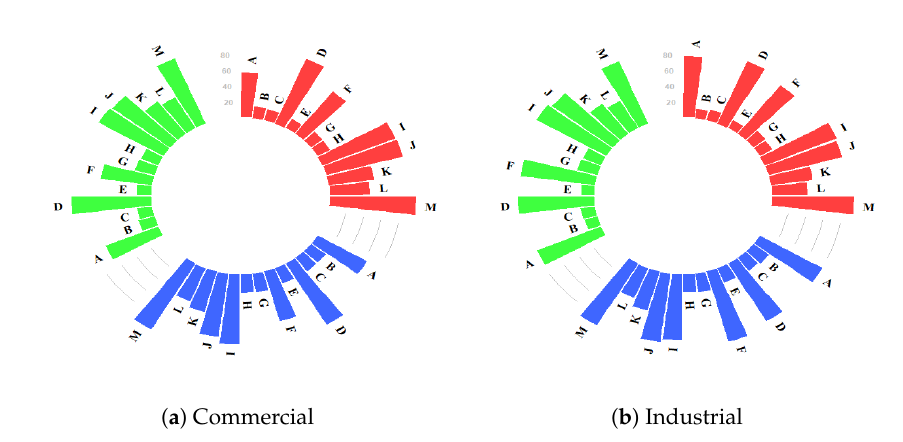
Figure 10. Radar plot for standardized sum of squared errors. Table 5. Performance Measures of proposed and homogeneous ensemble learning